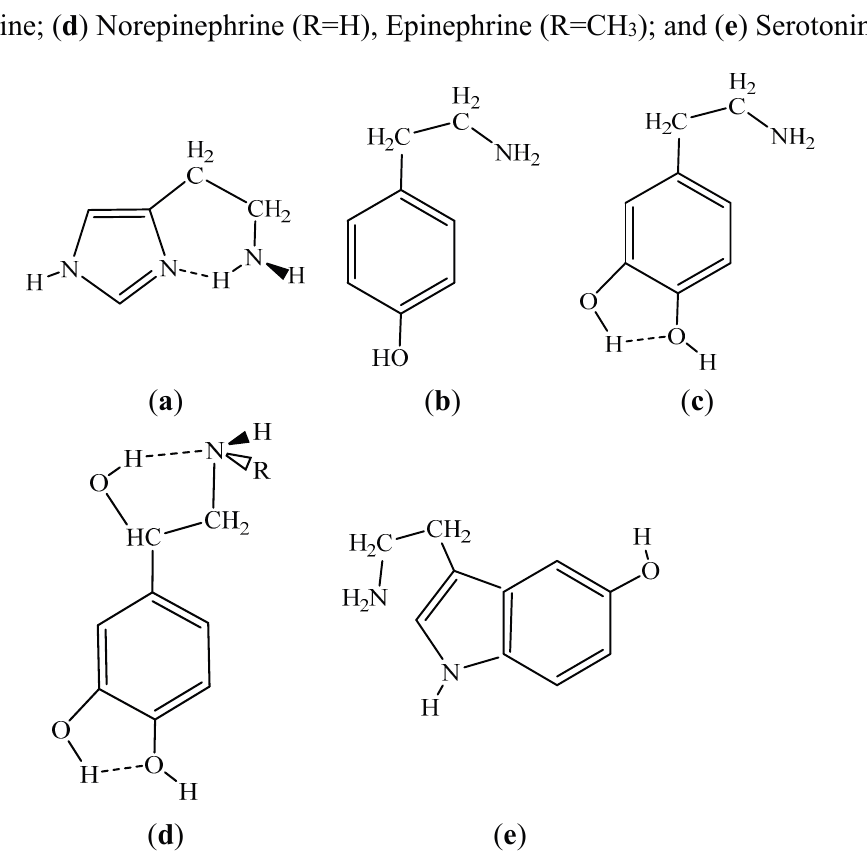
Figure 8. Neurotransmitters portrayed in the neutral form: ( a ) Histamine; ( b )